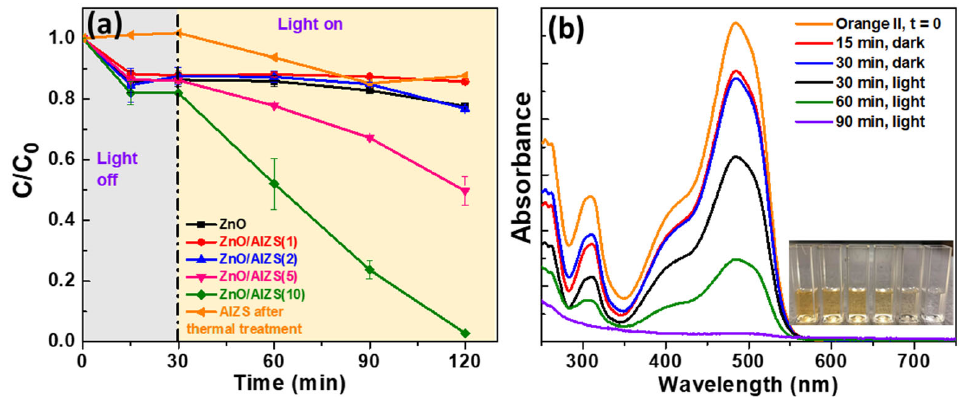
Figure 5. ( a ) Photocatalytic degradation kinetics of OA7 aqueous solution using AIZS QDs, ZnO NRs and ZnO/AIZS heterostructured photocatalysts and ( b ) evolution of UV-visible absorption spectra of AO7 during the photodegradation using the ZnO/AIZS(10) catalyst (the inset of b is a photograph of aliquots taken during the